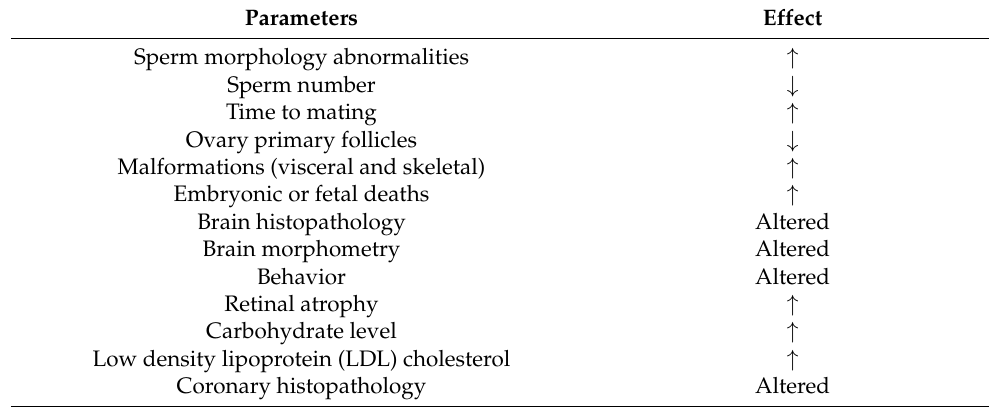
Table 1. Overview of adversities potentially related to an ED property of CS 2 . Parameters